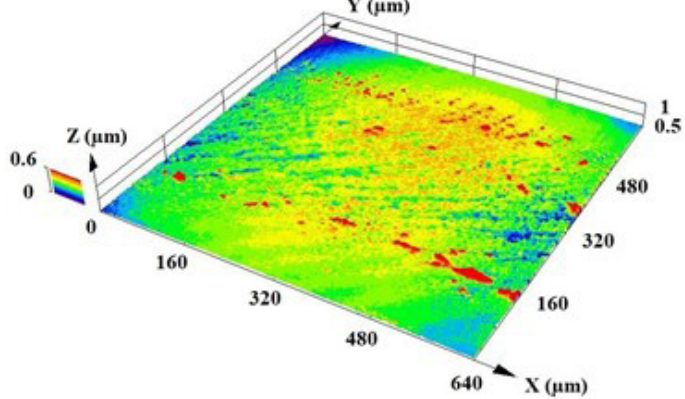
Figure 3. 3D profile of the wear track on the A70N30 composite, where the disc moved in the X direction.